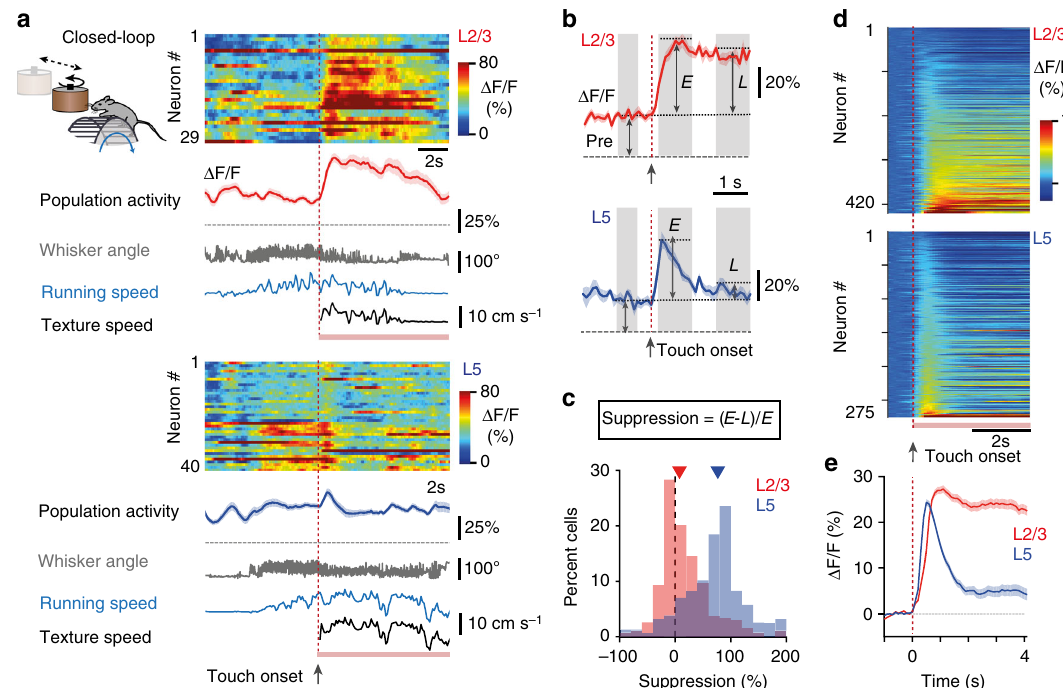
Fig. 3 Wall touch during running evokes sustained responses in L2/3 and transient responses in L5. a Population dynamics in L2/3 (left) and L5 (right) neurons for two example trials under the Closed-loop condition. The heat map represents Δ F / F calcium transients in pseudo-color code. Below the heat maps the population mean Δ F / F trace (solid line, ±s.e.m.), whisker angle (gray), running speed (blue), and texture speed (black) are shown. Touch onsets are indicated by red vertical dotted lines; pink bars represent periods of texture contact. b Mean Δ F / F traces aligned to touch onset (red dotted line) for an example L2/3 and L5 neuron. Shaded areas indicate windows for analysis (pre-touch, ‘ Pre ’ , − 1 to − 0.3 s; early, ‘ E ’ , 0.3 to 1.3 s; late, ‘ L ’ , 2 to 3 s). c Distribution of percent suppression as de fi ned in the equation for L2/3 and L5 touch-responsive neurons. Arrowheads mark medians of 76.6% and 7.7%, respectively. d Heat maps representing touch onset responses of all L2/3 (top, n = 420) and L5 (bottom, n = 275) neurons in Closed-loop condition.